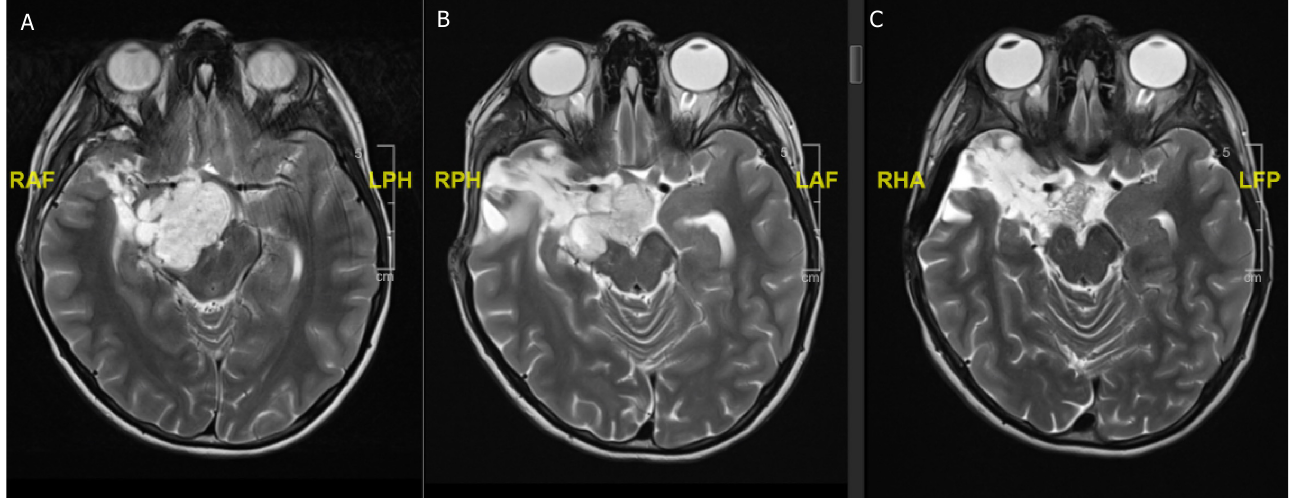
Figure 3. An 11-year-old boy presenting with headaches and blurry vision. ( A ) Preoperative MRI scan showing a 6.1 × 4.0 × 3.4 cm T2 hyperintense and contrast enhancing (not shown) lesion suggestive of (non-NF) optic pathway glioma. ( B ) Postoperative MRI scan after partial resection with tumor rest in the optic pathway. Histology confirmed a BRAF600 mutated pilocytic astrocytoma. ( C ) Follow-up MRI scan after 4 weeks of MEK inhibitor treatment showing a nearly complete regression of the tumor.